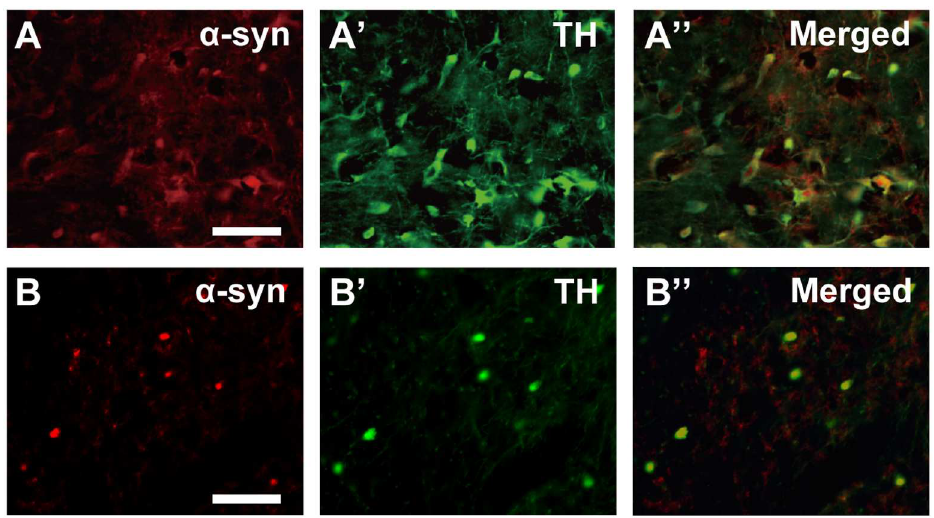
Fig 2. Photomicrographs of double immunofluorescencestaining for α -syn and TH in SNc at 10 (A,A’, A”) and 31 (B,B’,B”) years of age. Note that the intensity of α -syn is weak in many TH-positive neuronsat 10 years of age, and that the vast majority of TH-positive neuronsare clearly immunostained for α -syn at 31 years of age. Scale bars, 50 μ m.